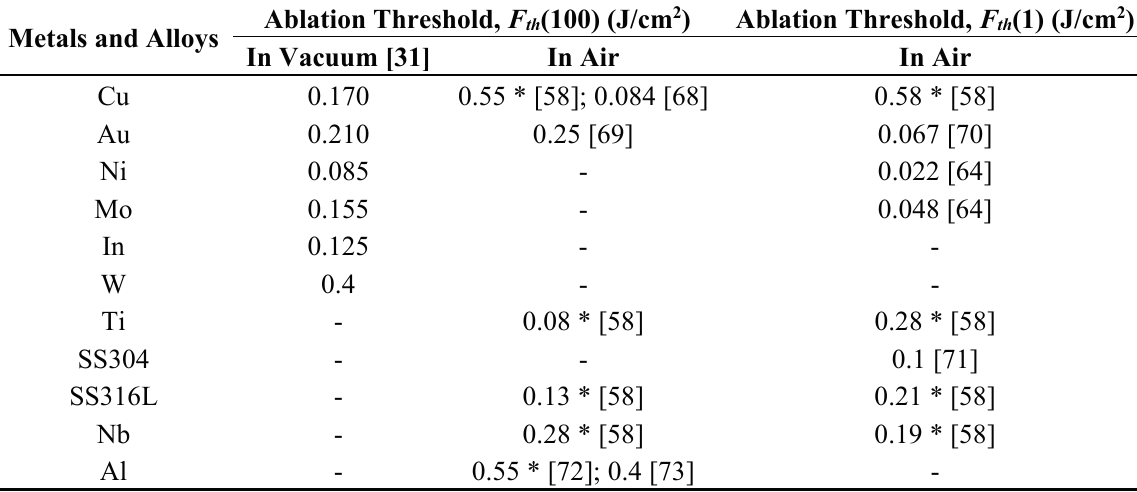
Table 1. Ablation thresholds for a single pulse and for 100 pulses for different metals ablated with femtosecond lasers. * The authors reported peak fluence